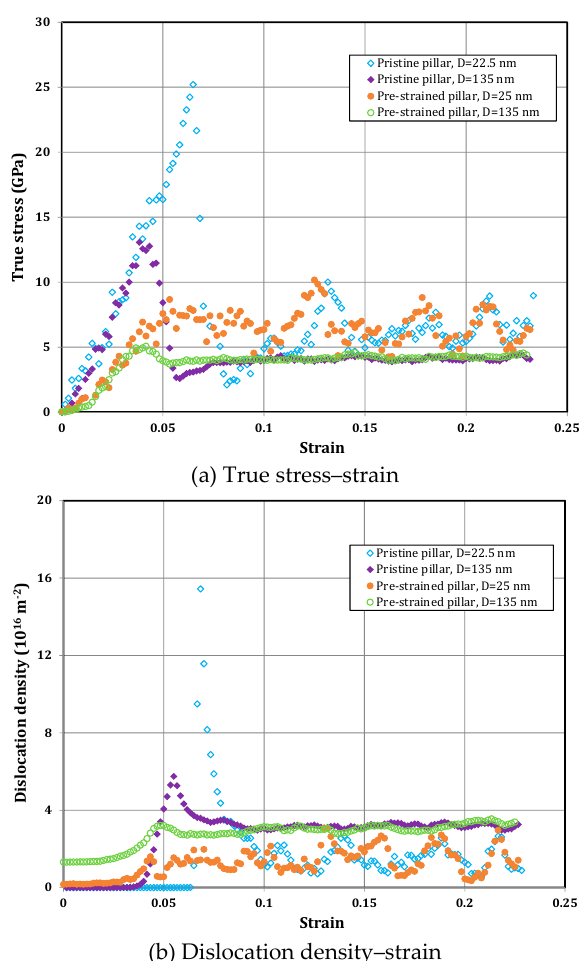
Figure 17. The responses of pristine and pre-strained samples during micropillar compression test in the cases of pillar with H = 45 nm and different diameters of 22.5 nm and 135 nm: ( a ) true stress–strain; ( b ) dislocation density–strain (after Yaghoobi and Voyiadjis [21]).